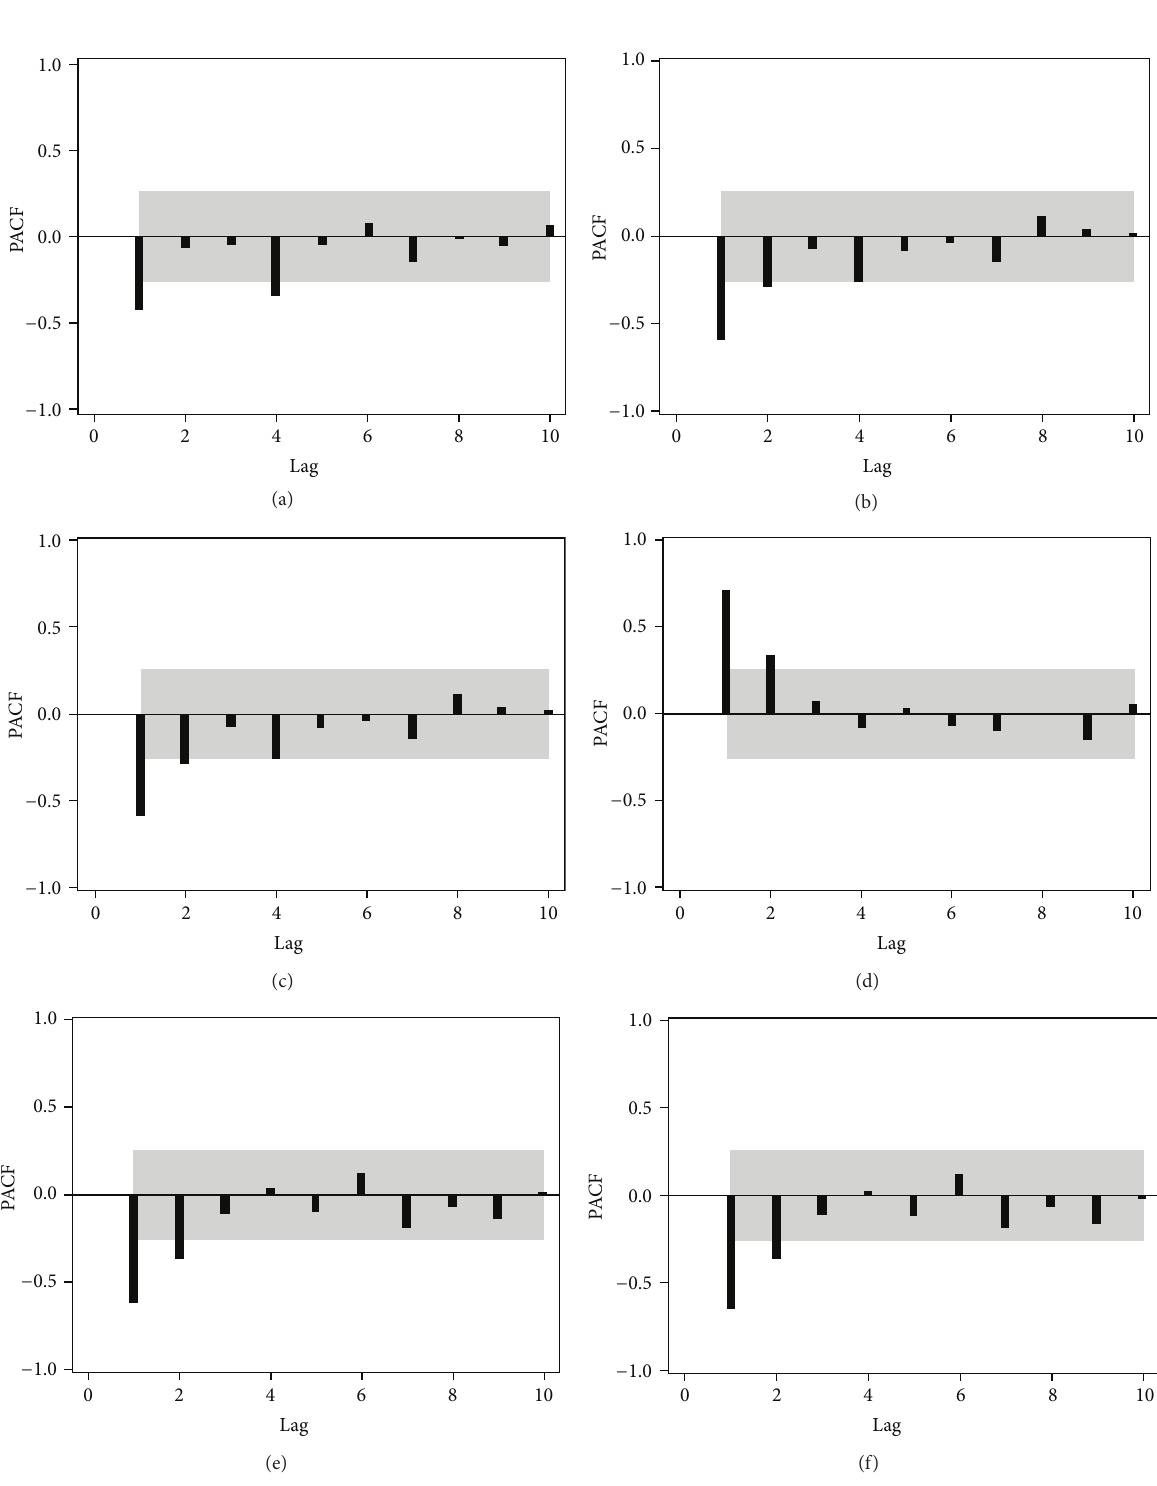
Figure 3: Partial autocorrelation function (PACF) for area, productivity, and production in Odisha and India. (a) Area (million hectare) in India; (b) productivity (kgha −1 ) in India; (c) production (million ton) in India; (d) area (million hectare) in Odisha; (e) productivity (kgha −1 ) in Odisha; and (f) production (million ton) in Odisha (shaded areas in the plots are significant at 5%